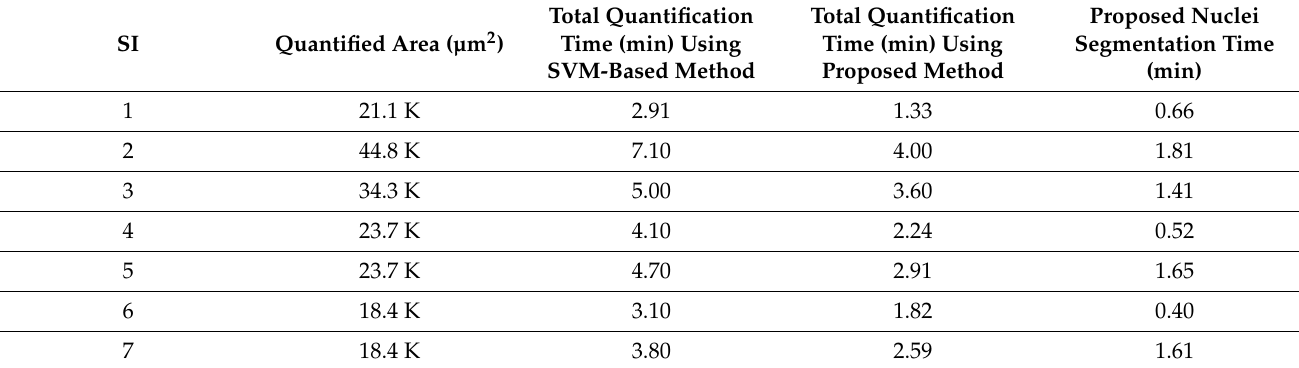
Table 3. HER2 grading based on HER2 and CEP17